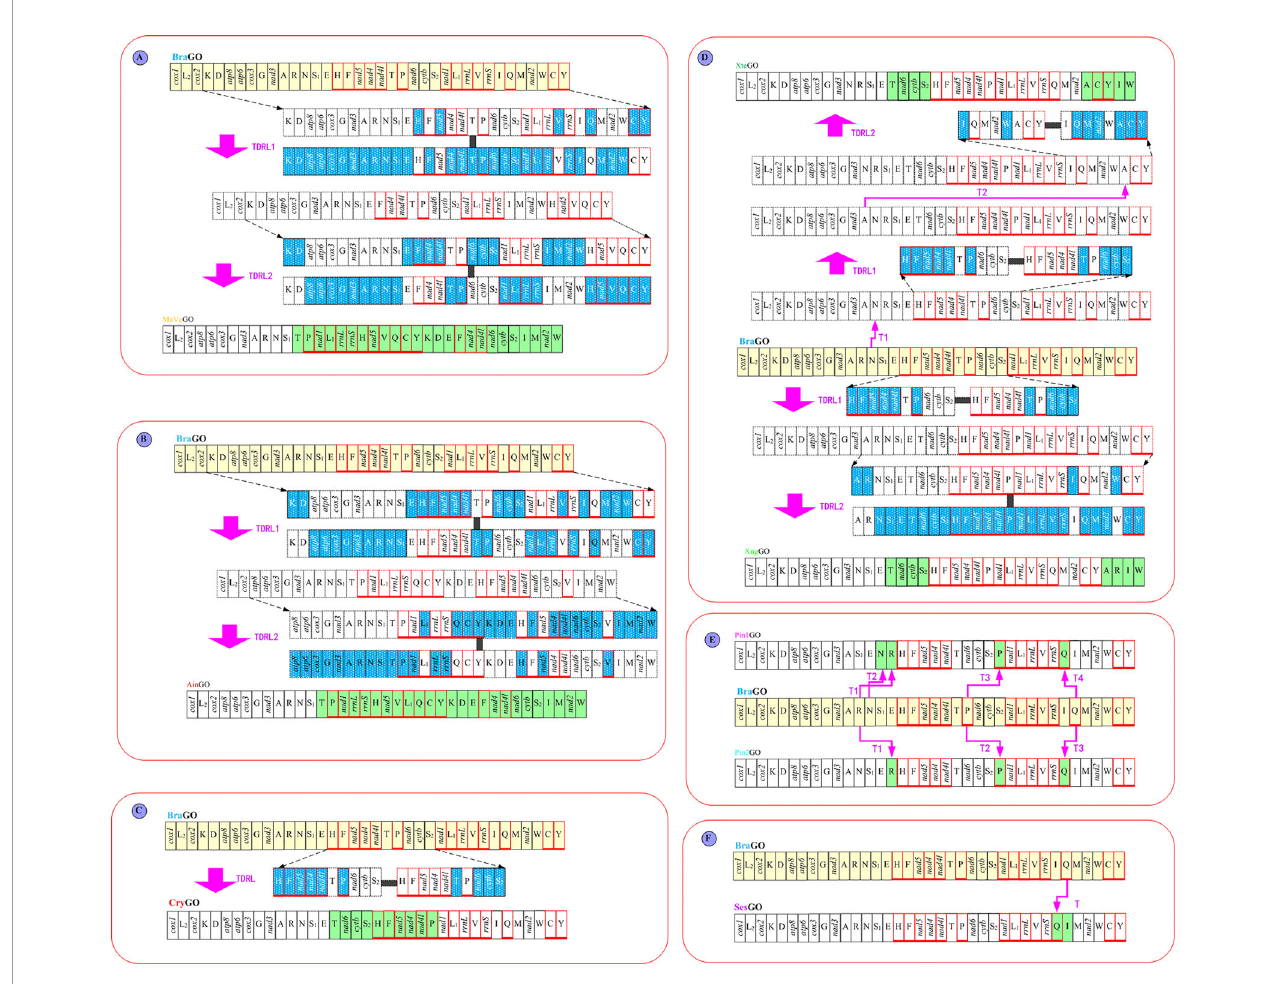
FIGURE 4 | The evolutionary pathways generating (A) MaVaGO, (B) AinGO, (C) CryGO, (D) XteGO and XngGO, (E) Pin1GO and Pin2GO, and (F) SesGO arrangements from BraGO. tdrl, tandem duplication random loss mechanism. T, transposition events. The genes involved in rearrangement events relative to BraGO were shown with a green